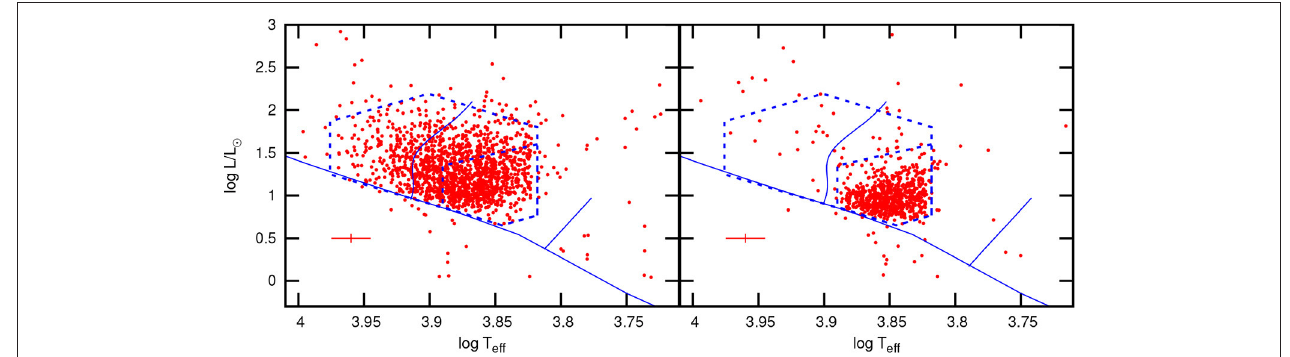
FIGURE 2 | Kepler δ Sct stars (Left) and γ Dor stars (Right) in the H-R diagram (dots). Gaia D2 luminosities are used. The solid lines are the zero-age main sequence (solar abundance from Bertelli et al., 2008) and the non-radial red and blue edges from Xiong et al. (2016). The dashed polygon defines the region which includes the majority of δ Sct (larger box) and γ Dor (smaller box) stars. The cross at bottom left shows the 1- σ error